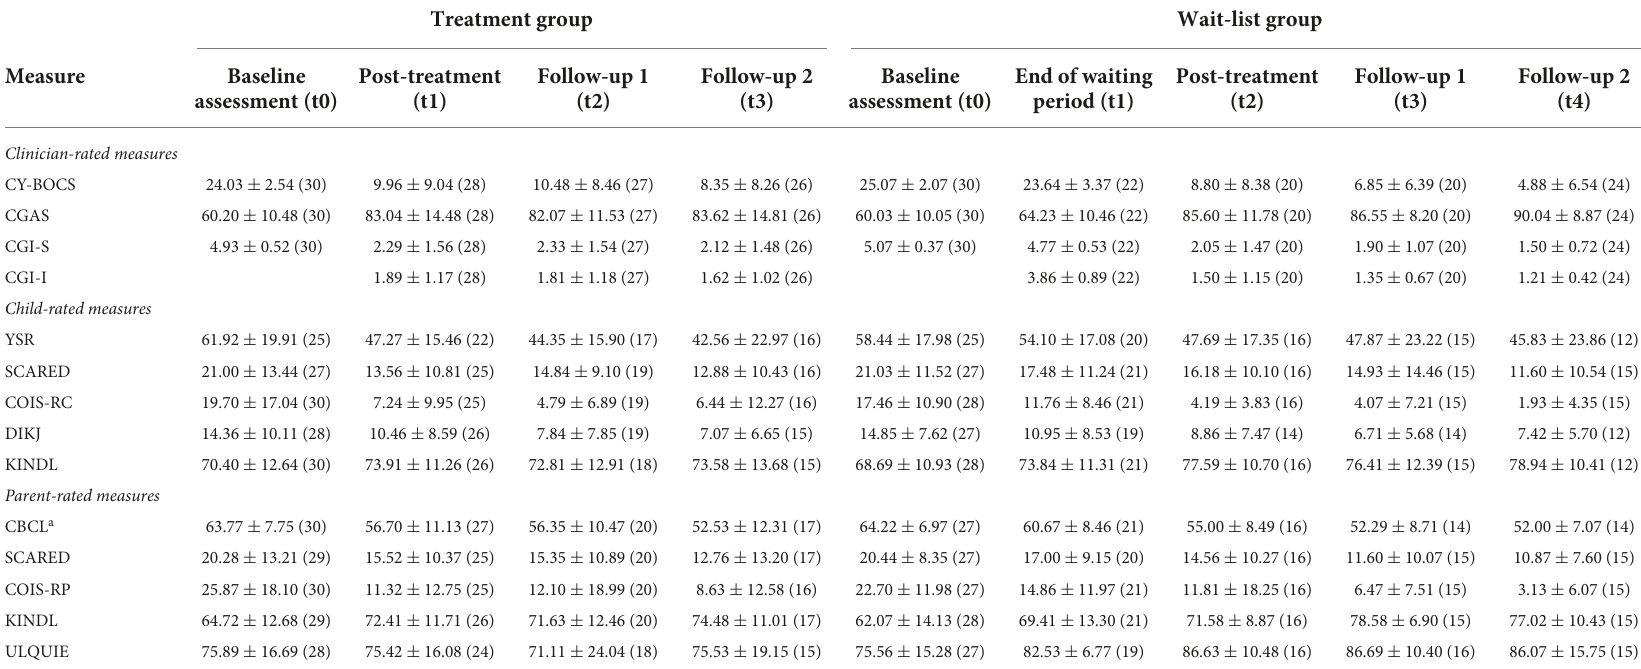
TABLE A1 Original data of primary and secondary outcome